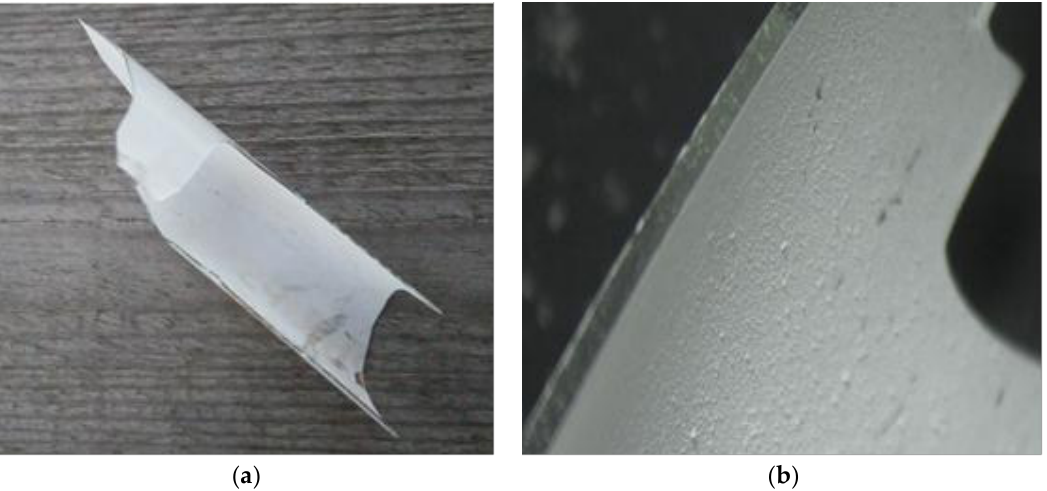
Figure 1. Wastes from lighting glass: ( a ) part of fluorescent lamp; ( b ) view of glass grain under an optical microscope.